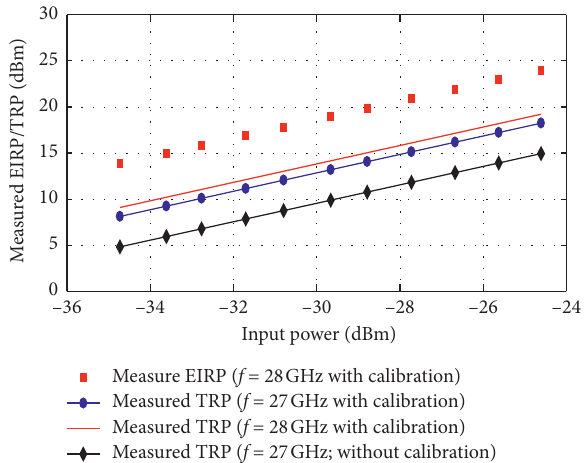
Figure 9: Measured EIRP and TRP (in dBm).